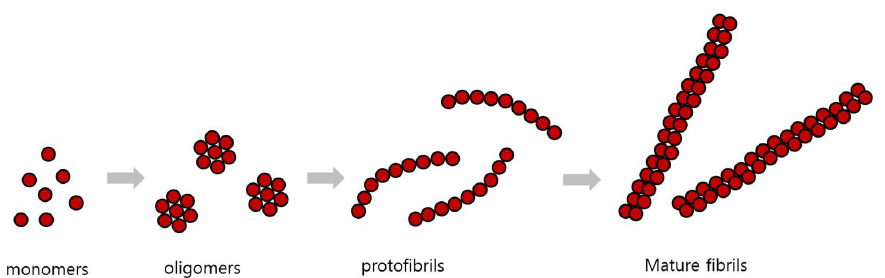
Figure 3. Aggregation of A β monomers to higher order oligomers, protofibrils and mature fibrils. A β monomers can form assemblies ranging from low molecular weight oligomers (dimers to pentamers) to mid-range molecular weight oligomers (hexamers to dodecamers). These oligomers can further aggregate into protofibrils and